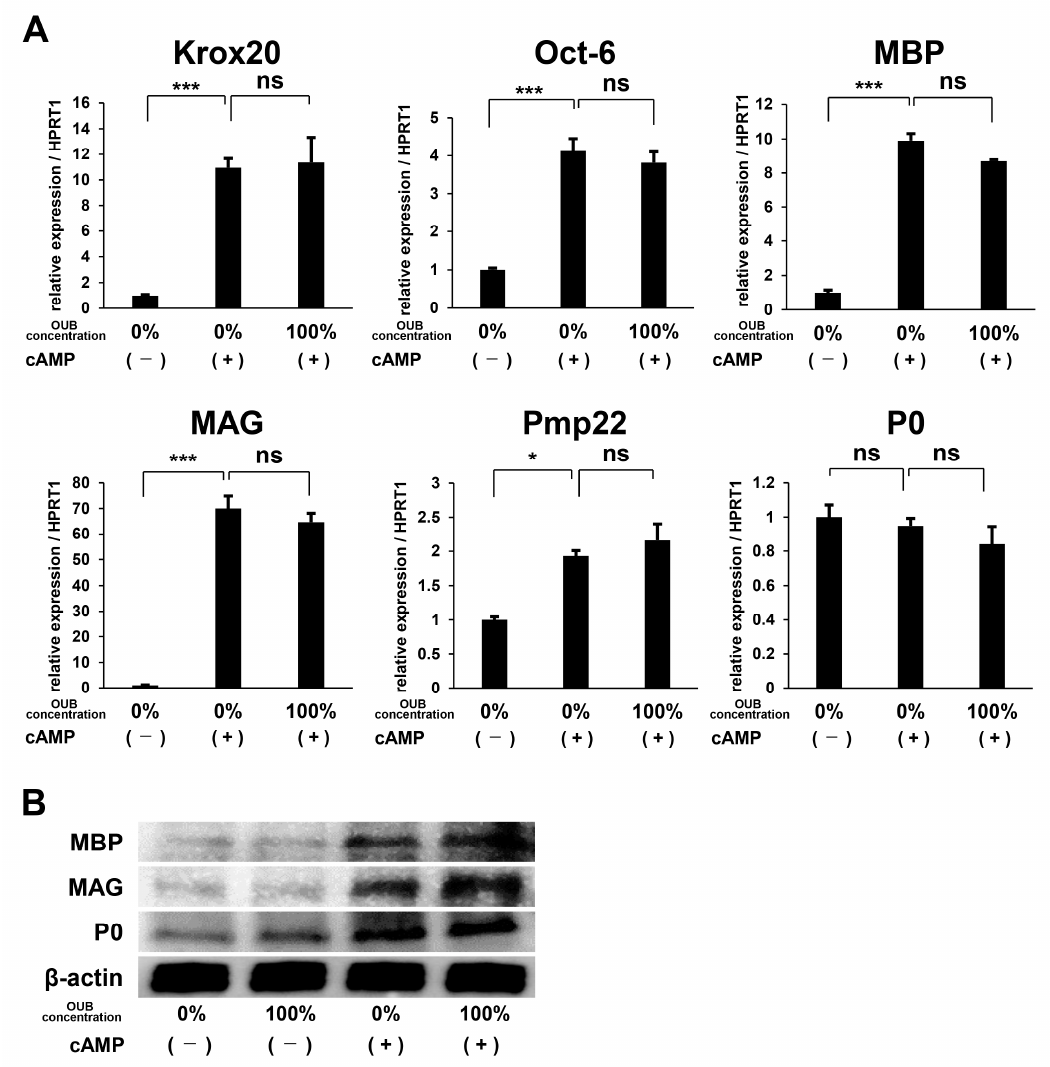
Figure 3. OUBs have no effects on the differentiation of Schwann cells (SCs). ( A ) Change in gene expression for differentiation makers including myelination-associated transcription factors (Krox20 and Oct-6) and myelin genes (MBP, MAG, Pmp22, and P0) were examined using SCs cultured in the differentiation medium containing db-cAMP with or without OUBs. HPRT1 was used as an internal control; ( B ) western blotting of myelin-related proteins (MBP, MAG, and P0) in SCs cultured in both growth medium and differentiation medium containing db-cAMP with or without OUBs. β -actin was used as an internal control. The data were analyzed by one-way ANOVA followed by Dunnett test. Graphs show indicate mean ± SD. Results are representative of three independent experiments.